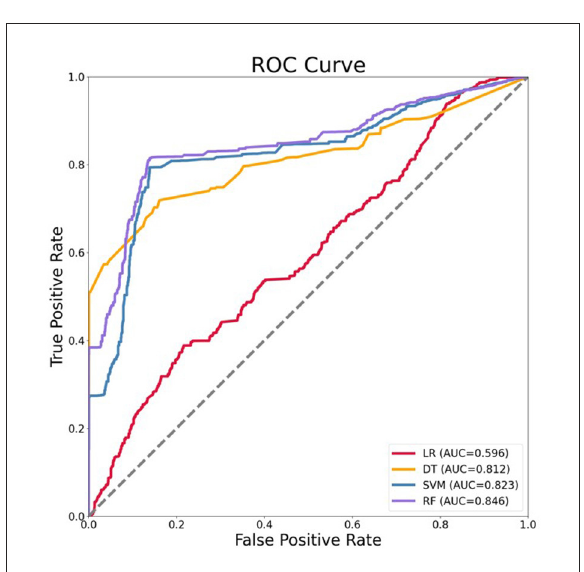
models in SMOTE-processed data were better than traditional logistic regression model, in which the RF model performed best (accuracy = 0.871, precision = 0.960, recall =